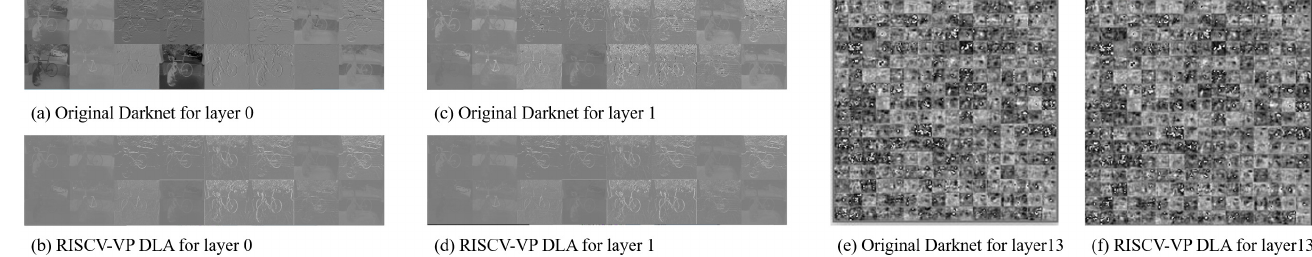
Figure 6. Experimental results of running on RISC-V VP DLA system and running of Original Darknet library for layer 0, 1 and 13 of Darknet Yolo tiny v3 Nueral Network Model, which are convolution of 416 × 416 image with 16 filters ( a , b ), max pooling of 16 416 × 416 images ( c , d ), and convolution of 13 × 13 image with 1024 filters ( e , f ),